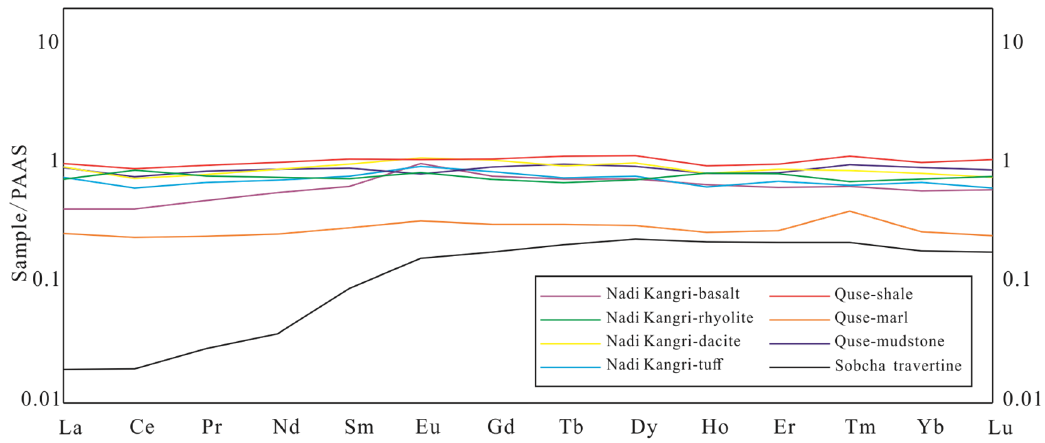
Figure 11. Comparison of PAAS-normalization patterns between Sobcha travertines and potential source rocks: basalt, rhyolite, and dacite of the Nadi Kangri volcanic rocks (data from Fu et al. [93]); tuff of the Nadi Kangri volcanic rocks (data from Wang et al. [96]; Fu et al. [97]; Wang et al. [98]); shale of the Quse Formation (data from Fu et al. [50]); mudstone of the Quse Formation (data from Nie et al. [95]); and marl of the Quse Formation (data from Fu et al.